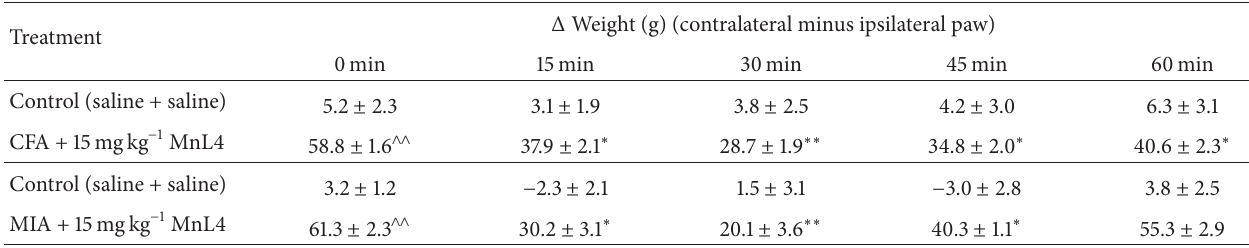
Table 1: Effect of MnL4 on hind limb weight bearing alterations induced by CFA or MIA.